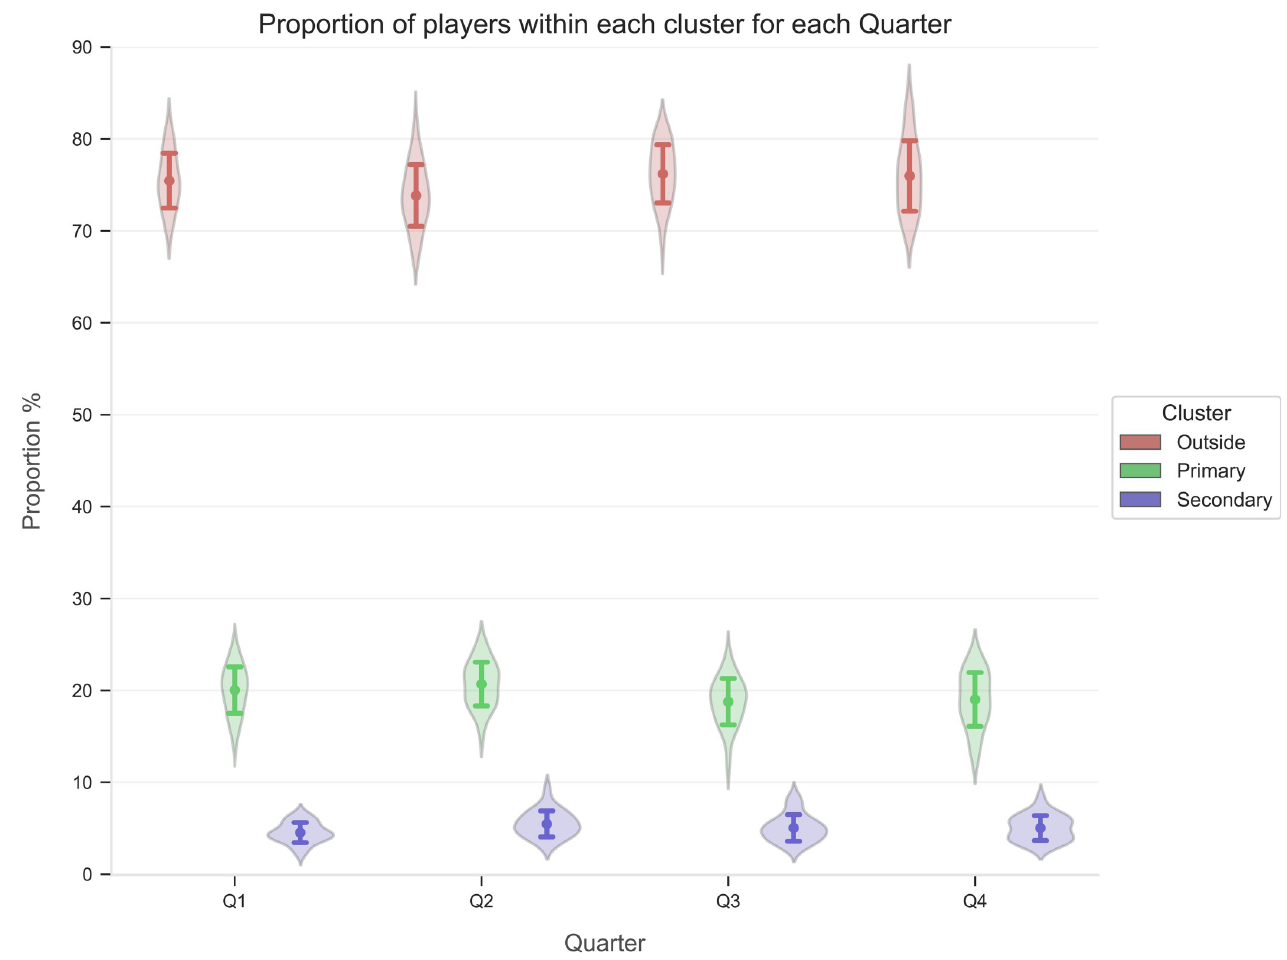
Fig 3. Proportion of players (mean ± standard deviation) in each cluster compared across quarter. Q1, Quarter 1; Q2, Quarter 2; Q3, Quarter 3; Q4, Quarter 4.